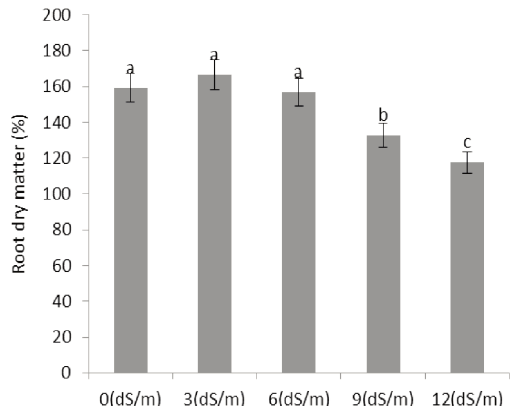
Fig. 3 ­ Effects of water salinity on root dry matter percentage of pomegranate cultivar.